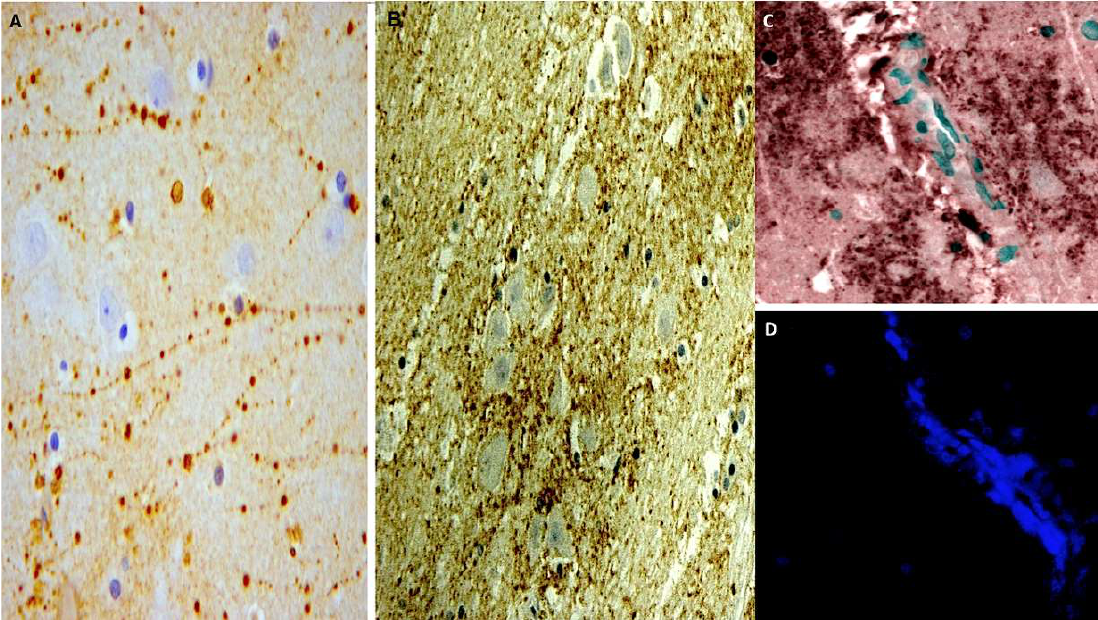
Figure 6. ( A ) AQP4 expression in group 5 (14 days): widespread immunopositivity is evidenced in brown color. ( B ) Diffuse perivascular AQP4 positivity reactions (brown) in group 6 (30 days). ( C ) Double immunoreactions for CD15 and AQP4: isolated immunopositivity in group 5 (14 days) for CD15 demonstrated by the dark reaction, and diffuse immunopositivity for AQP4 in green. ( D ) Confocal microscopy: diffuse reaction in group 6 (30 days); AQP4 is intensely positive (blue color) (magnification 150×).